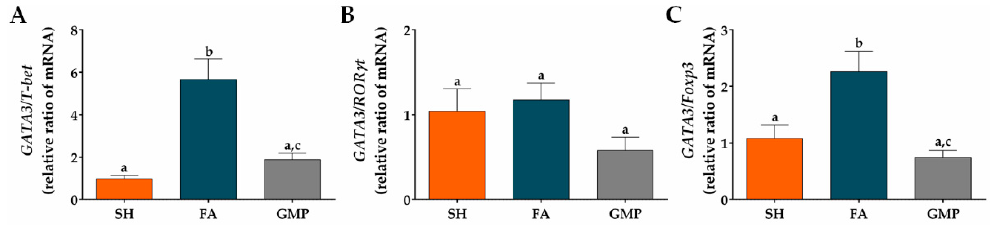
Figure 9. E ff ect of treatment with glycomacropeptide (GMP) on the skew of the immune response in the intestinal environment. Ratios of mRNA expression of ( A ) GATA3 / T-bet , ( B ) GATA3 / ROR γ t and ( C ) GATA3 / Foxp3 in intestinal tissue of experimental groups. Intestinal expression level of transcription factors relative to β -actin was analyzed by quantitative PCR and expressed as relative ratio of mRNA ( n = 4). SH, sham control; FA, FA-induced; GMP, FA-induced and GMP-treated animals. Di ff erent letters (a,b,c) indicate statistical difference.